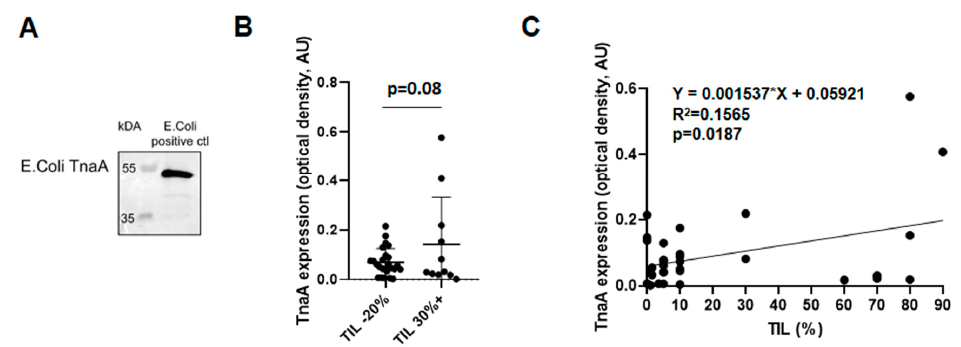
Figure 10. The fecal protein expression of E. coli TnaA is higher in patients with higher proportions of tumor-infiltrating lymphocytes. ( A ) E. coli total lysate was run on an SDS-PAGE gel, transferred to nitrocellulose membrane, and probed with an anti-TnaA antibody. ( B , C ) Fecal samples of 36 low tumor-infiltrating lymphocyte (TIL) patients (0–20% TIL) and 11 of high TIL patients (30%< TIL) were assessed by Western blotting using an anti-TnaA antibody. Protein content-normalized values were obtained. Values were tested for outliers using Grubb’s method; one value was omitted from the low TIL group. ( B ) Normalized TnaA expression was plotted. ( C ) On values from low and high TIL patients, liner regression was performed.